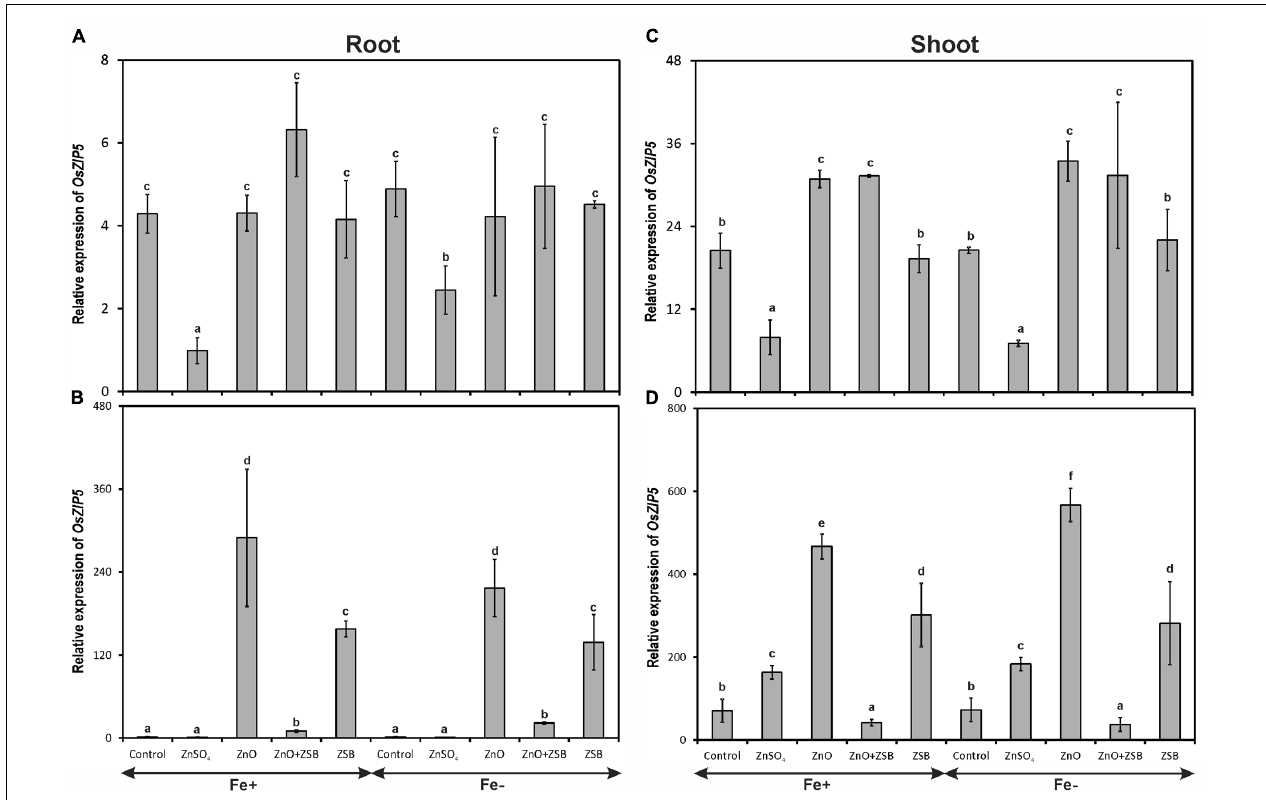
FIGURE 3 | Expression pattern of OsZIP5 in root (A,B) and shoot (C,D) of rice seedlings as influenced by Fe and Zn. (A,C) 7th day expression levels; (B,D) 14th day expression levels. Fe + , Fe sufficient condition; Fe − , Fe deficient condition. Control, No-zinc control; ZnSO 4 at 5 mM; ZnO at 10 mM; ZSB, Zinc solubilizing bacteria ( Enterobacter cloacae strain ZSB14) inoculation on 7th day. Relative mRNA abundance of OsZIP5 was quantified and normalized with OsACTIN1 gene on 7th day and 14th day. Data from real-time RT-PCR experiments were analyzed according to the 2 − (cid:49)(cid:49) Ct method. Means of six replicate values plotted, errors bars indicate the standard error. Values followed by the same letter in each panel are not significantly different from each other as determined by DMRT ( p ≤ 0.05).